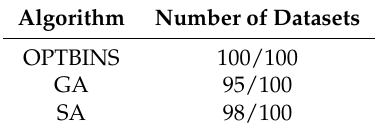
Table 2. Number of datasets for the d = 2 with equal binning v selected as the EXHOPTBINS algorithm.